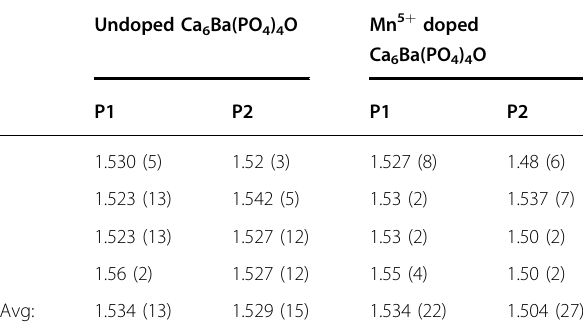
Table 2 P – O bond lengths (A ̊ )